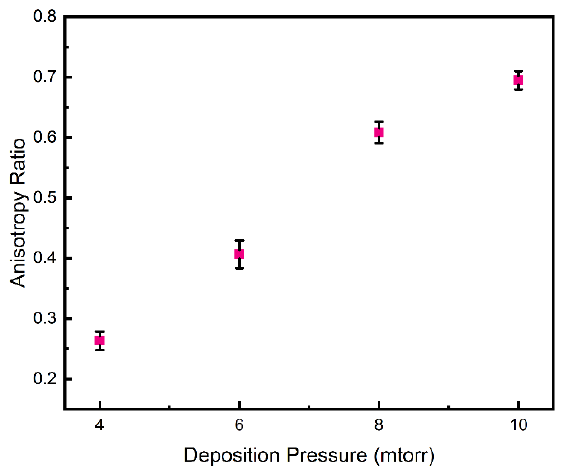
Figure 7. Anisotropy ratios of sidewall film thickness to bottom thickness for different deposition pressures.